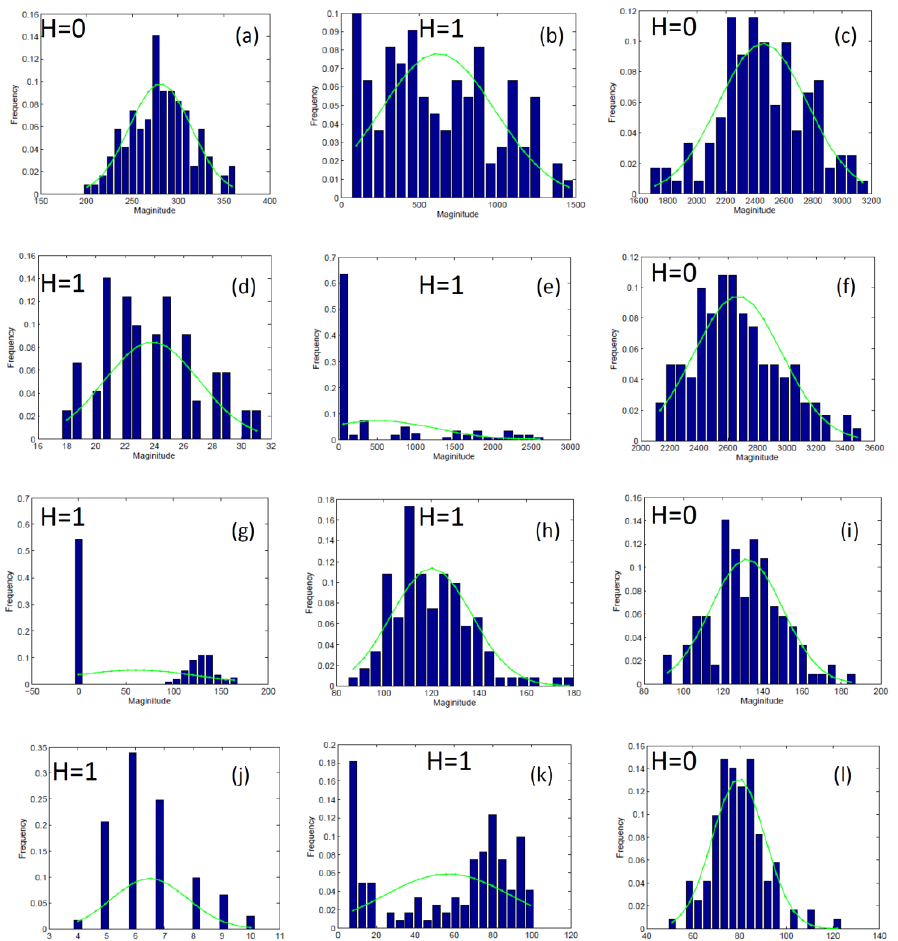
Figure 3. Signal magnitude histograms of an image patch from di ff erent marginal areas. “H = 0” means the data passes the test of normal distribution while “H = 1” means it does not. ( a ) An image patch with signal magnitude histogram (ocean water) from region A of Figure 2. ( b , c ) Image patches with magnitude histogram from poor signal (black margin) and e ff ective signal (glacier) respectively in region C of Figure 2. ( d – f ) Magnitude histograms of image patches from noise, noise + e ff ective signal, and e ff ective signal, respectively, in region B of Figure 2. ( g – i ) Magnitude histogram changes of signals from data gaps and land surface, non-normally distributed land surface, and normally distributed land surface respectively in region D of Figure 2. ( j – l ) Magnitude histogram of noise, noise + e ff ective signal, and e ff ective signal, respectively, in region E (sea surface and sea ice region) of Figure